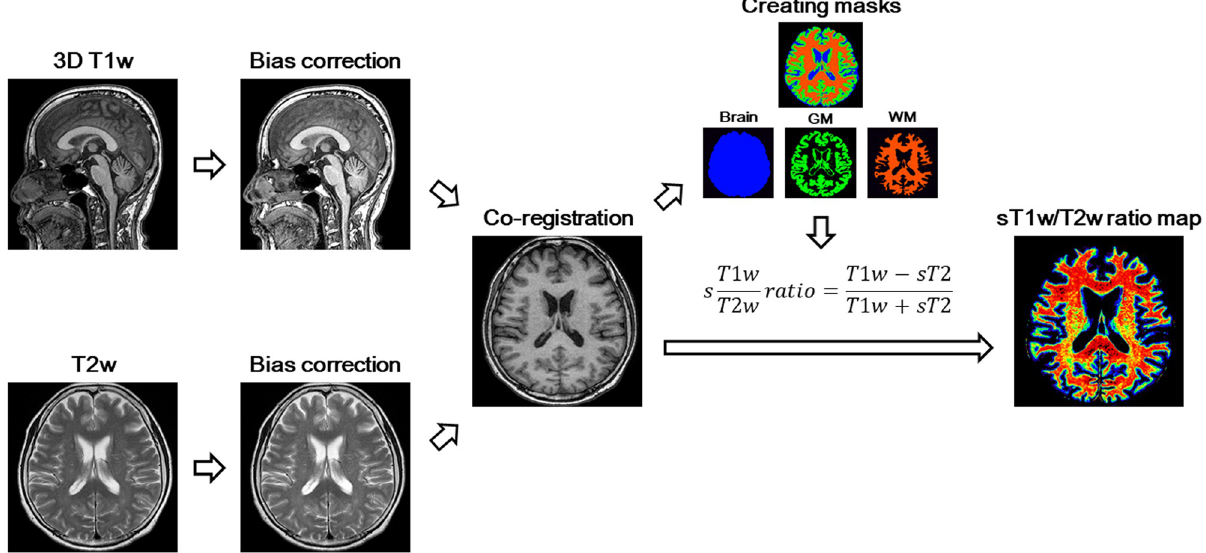
Fig 1. Schematic representation of the pipeline for creating a sT1w/T2w ratio map. T1w, T1-weighted; T2w, T2-weighted; GM, gray matter: WM, white matter; sT2, a scaled T2-weighted image.